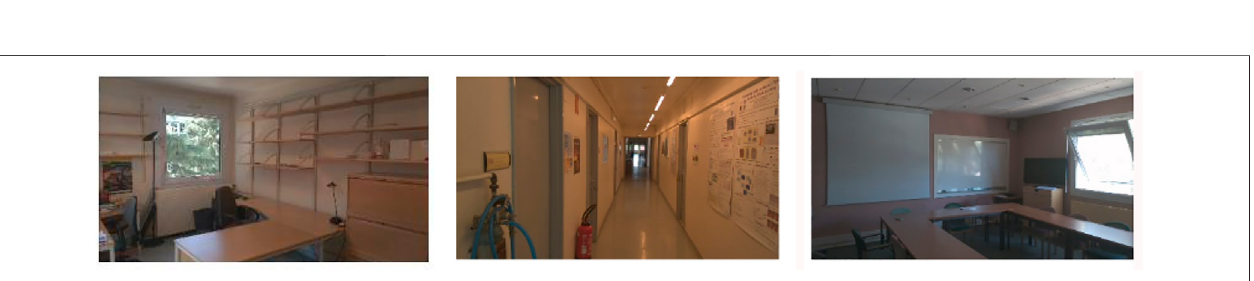
FIGURE 10 | Comparison of the percentage of frames where two planes were detected n (ordinate axis) for both planar segmentations algorithms depending on the inter-planes distance D (abcissa) for each different con fi guration of x .